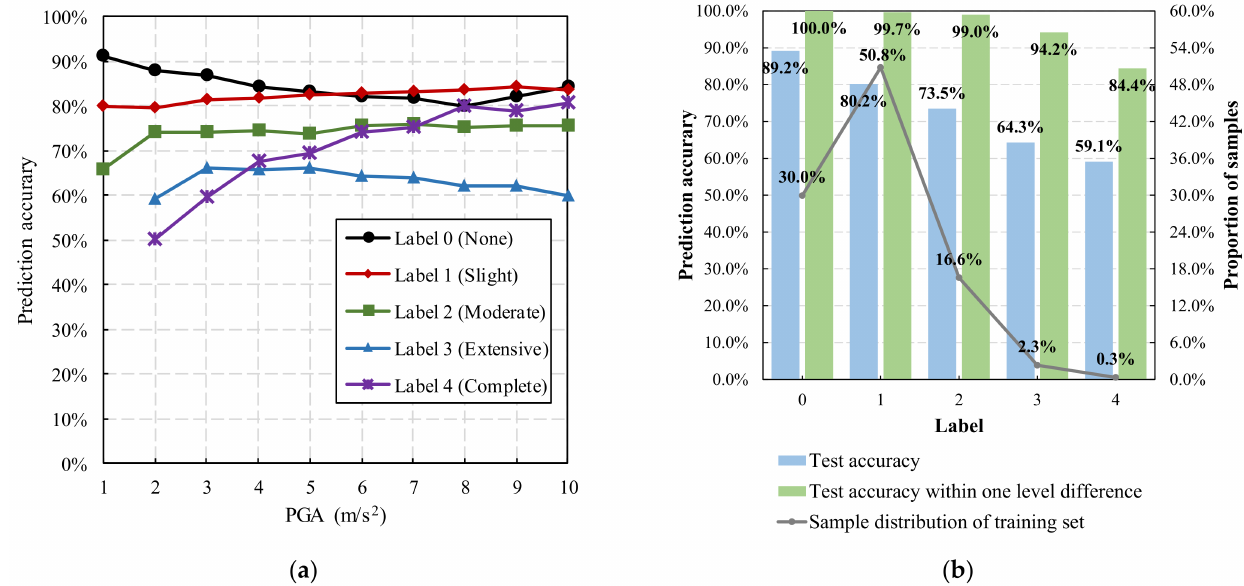
Figure 9. Influence of PGA on prediction accuracy: ( a ) prediction accuracies for samples with different PGAs; ( b ) distribution and prediction accuracy for samples with PGA of 1–3 m/s 2